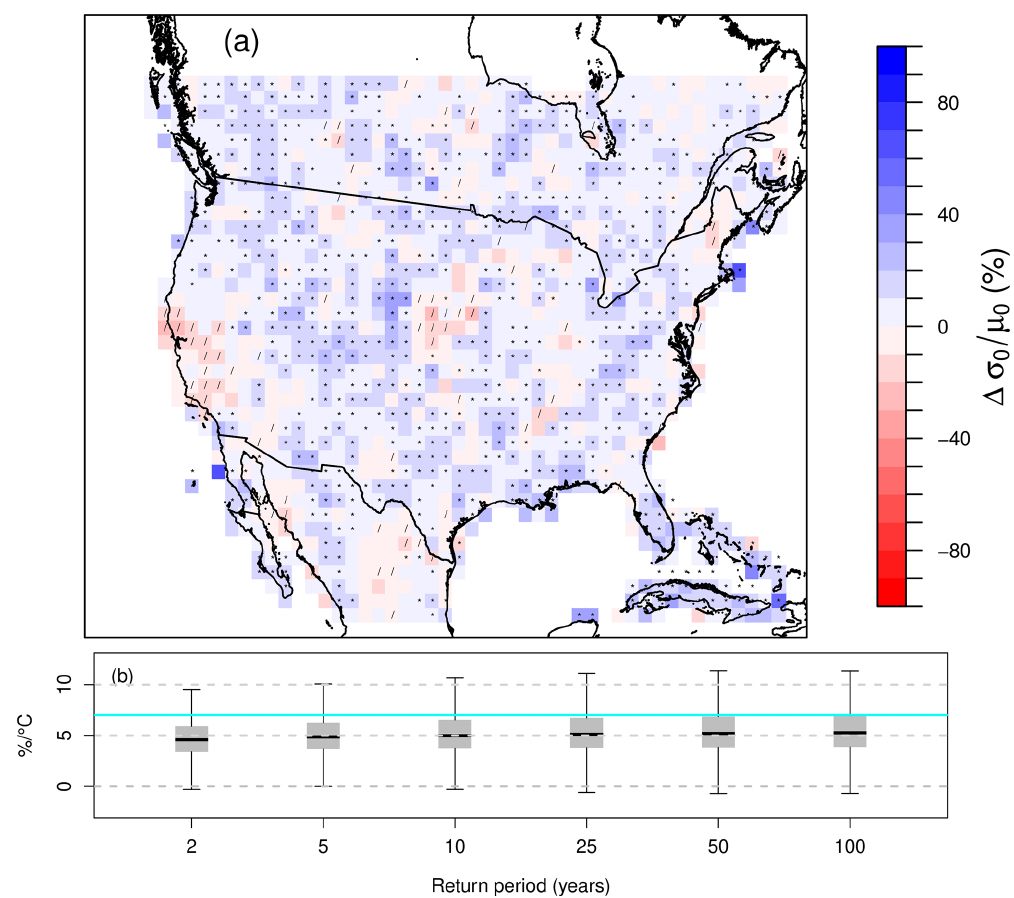
Figure 11. Projected changes in (a) GEVSS dispersion σ 0 /µ 0 . Values shown are aggregated 100km × 100km grid box means; boxes in which more than half of the 4km WRF grids show significant increases (decreases) are marked with a ∗ ( / ). (b) Box plots summarizing the distribution of temperature scaling values for 2- to 100-year return levels of 24h duration extreme rainfall; the horizontal cyan line indicates temperature scaling of 7% ◦ C − 1